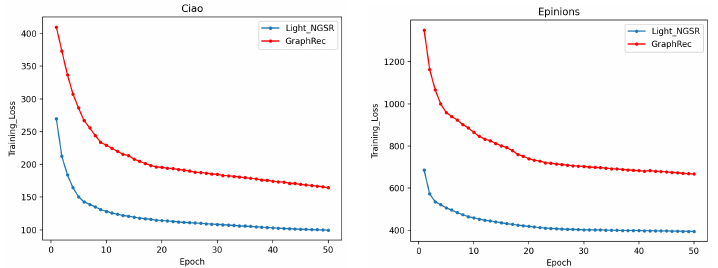
Figure 5. Training efficiency